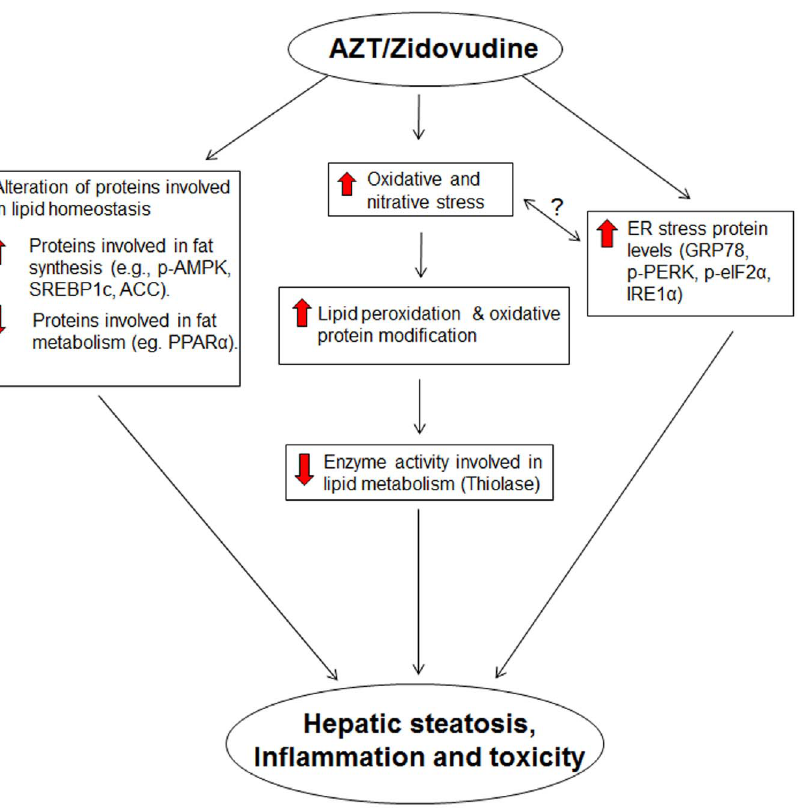
Figure 7. Schematic diagram describing potential mediators of AZT-mediated steatosis and injury. AZT-induced hepatic fat accumulation and injury is mediated through increased oxidative and nitrative stress, lipid peroxidation, protein modifications and